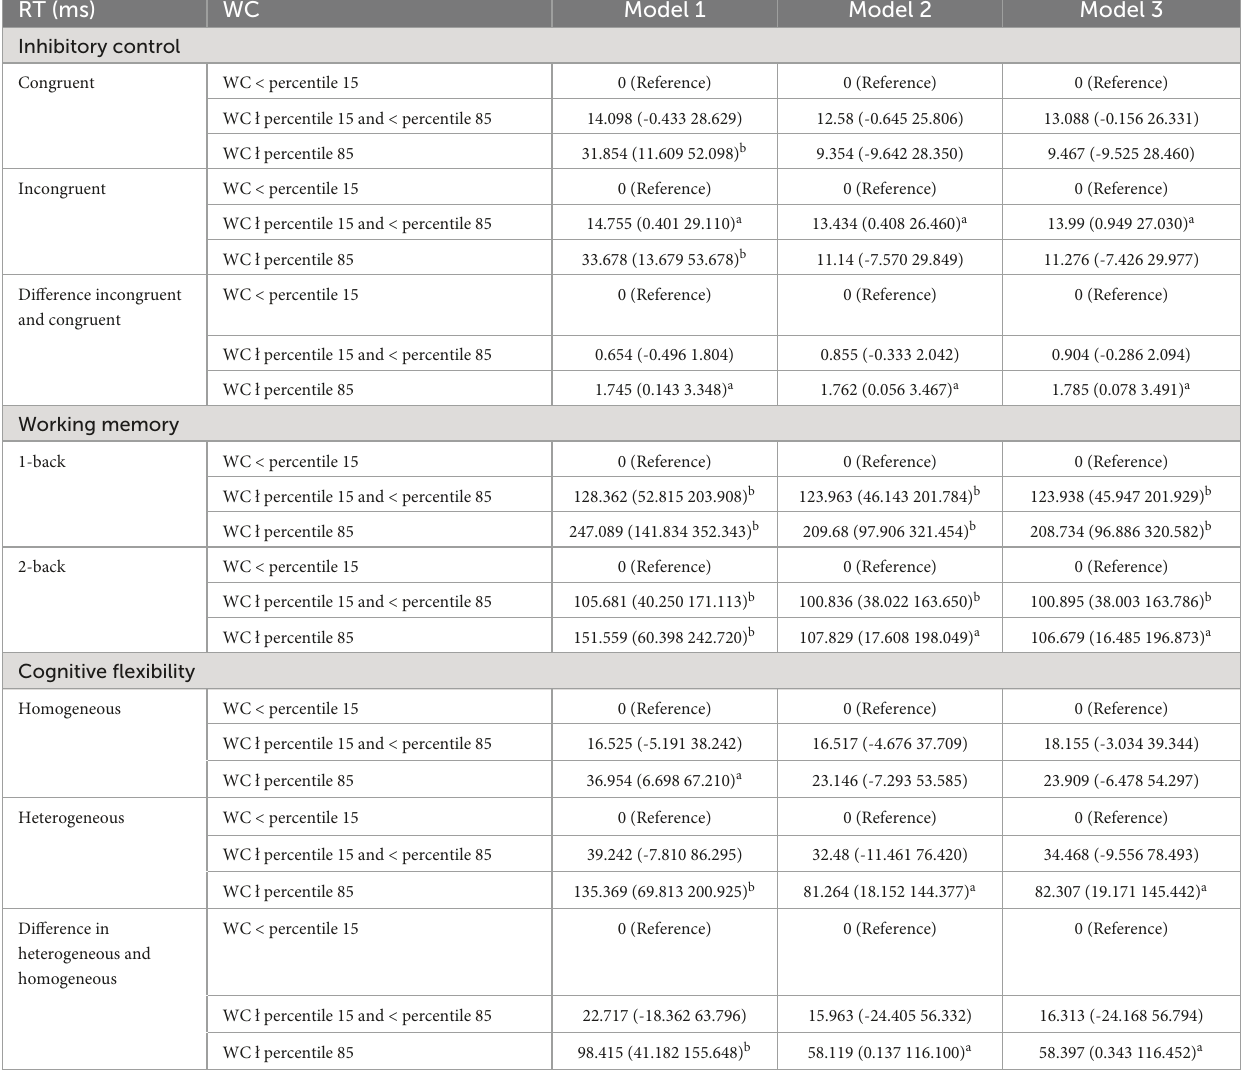
TABLE 4 The multiple linear regression of executive function by WC percentile groups ( n =